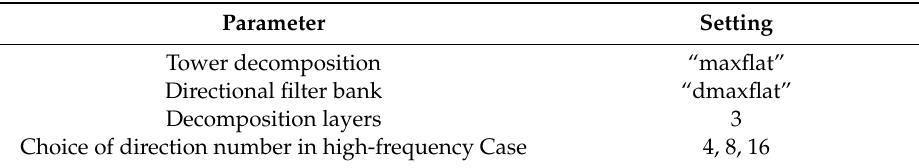
Table 1. Parameter settings for NSCT.